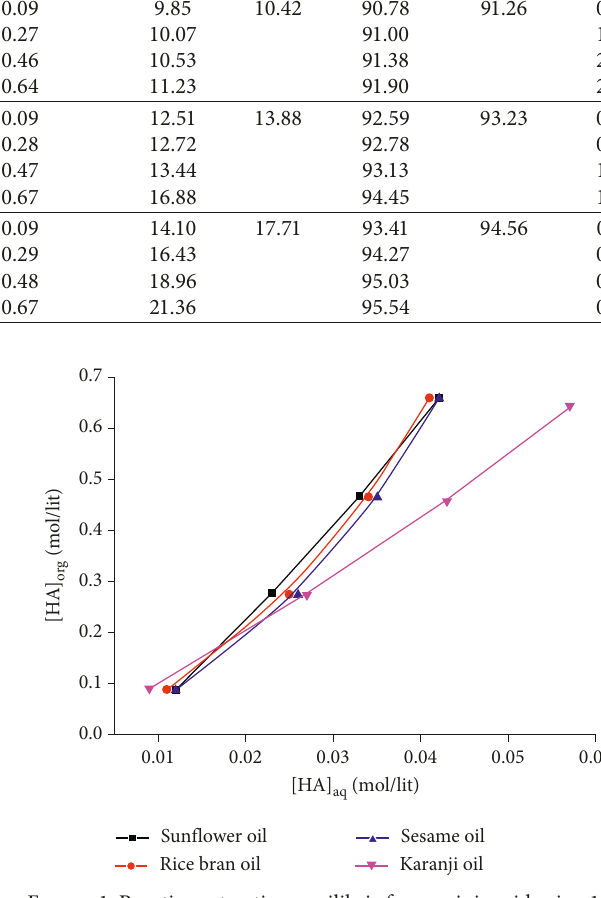
Table 5: Extraction equilibrium results for succinic acid and TOA in karanji oil biodiesel at 298K. TOA (vol.%)